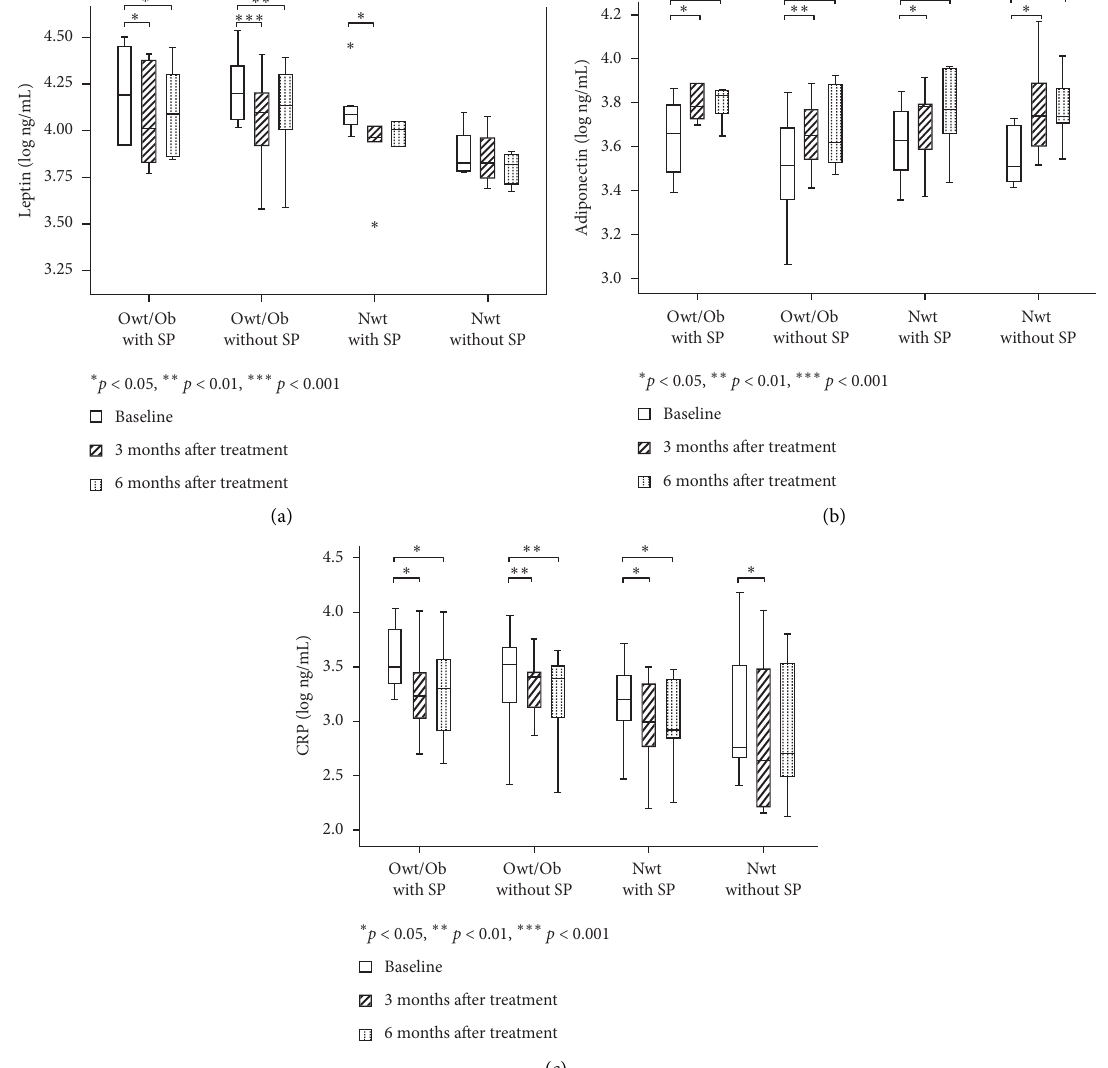
Figure 2: Cytokine levels at baseline, as well as at 3 and 6 months after NSPT, according to body mass index (BMI) and periodontal disease status: (a) leptin, (b) adiponectin, and (c) C-reactive protein. Differences were compared by the Friedman test; significant differences for pairwise comparisons were determined by the Wilcoxon matched-pairs signed-rank